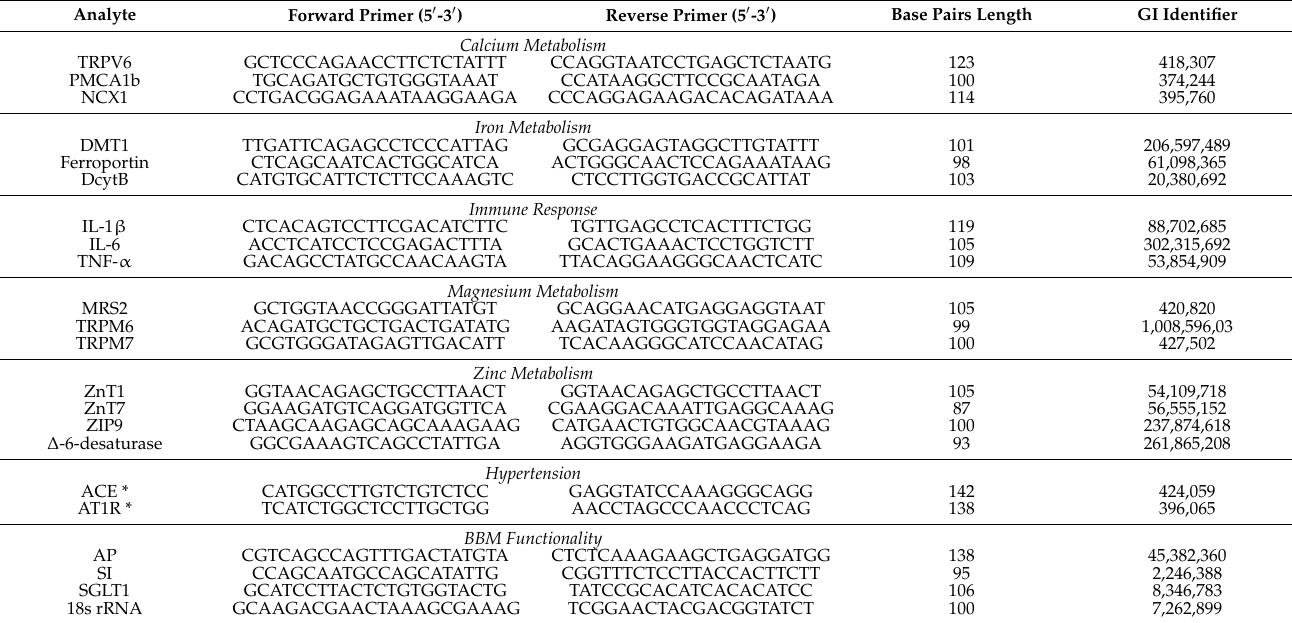
Table 1. Sequences of experimental